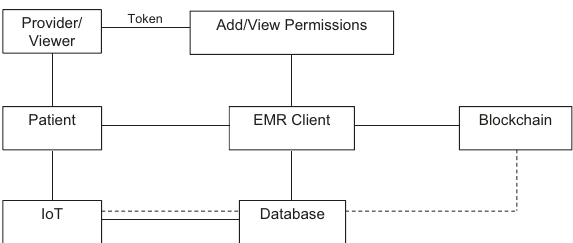
Fig. 2 Interactions in the Blockchain-based healthcare system. Patients have full access to the data via the EMR Client. Data may be added or viewed by doctors and other providers, who require permissions to do so, and added by devices including wearables, which form a part of the Internet of Things (IoT). All interactions are stored on the